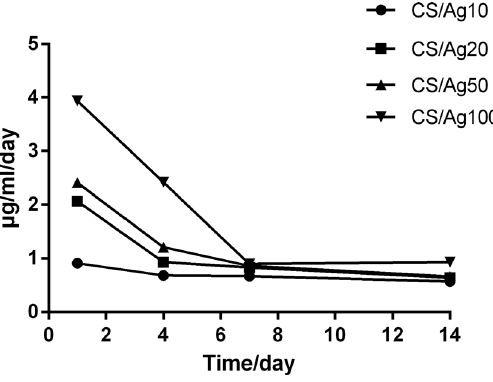
Fig 4. Non-cumulative silver release profile in